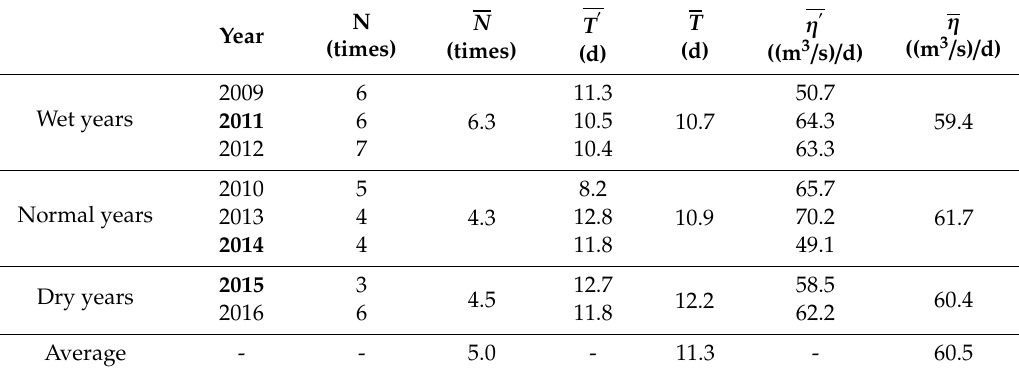
Table 2. Characteristic parameters of natural flow process in different years.